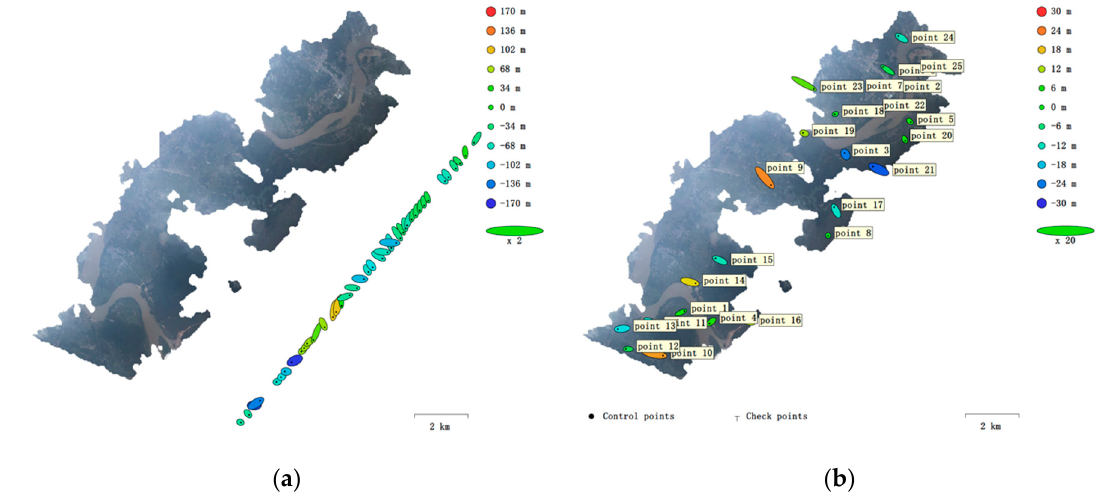
Figure 6. ( a ) Camera locations and error estimates, and ( b ) ground control points (GCP) locations and error estimates. Z error is represented by ellipse color. X, Y errors are represented by ellipse shape.